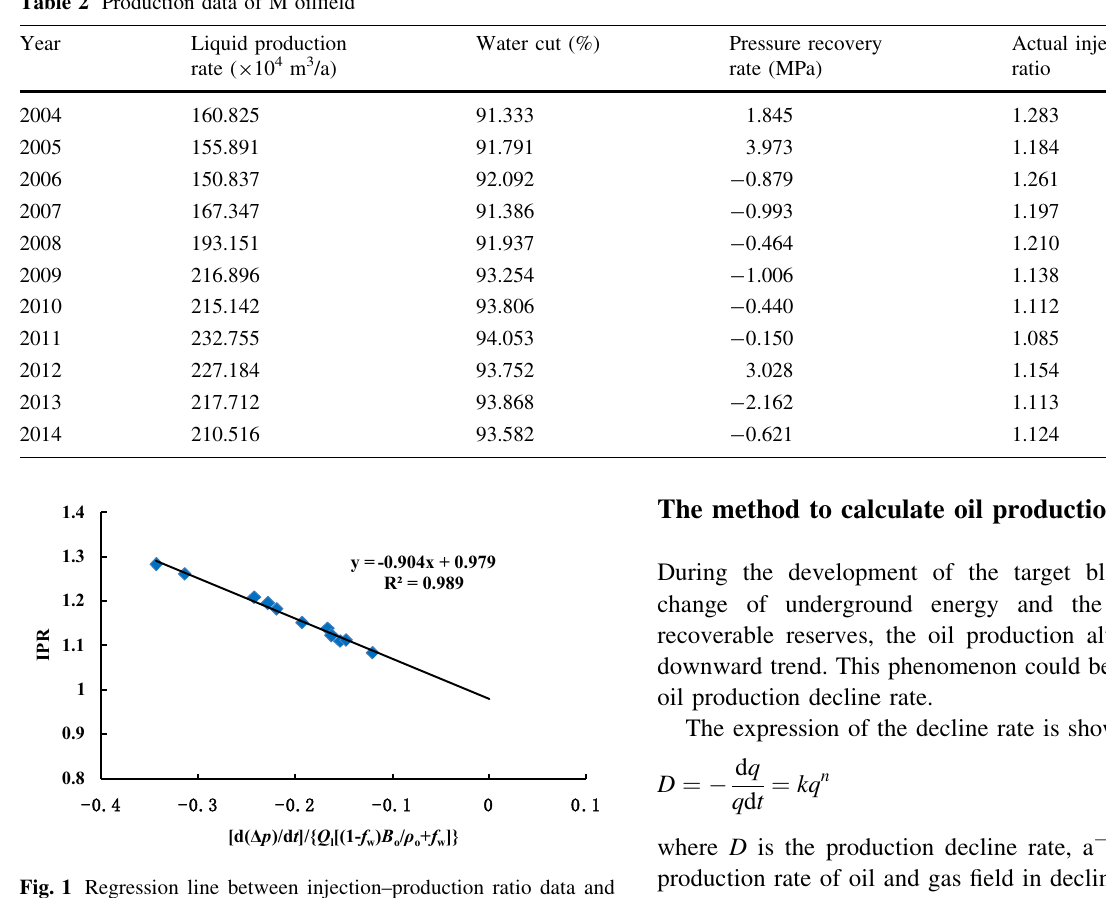
Table 2 and Fig. 1 show that injection–production ratio